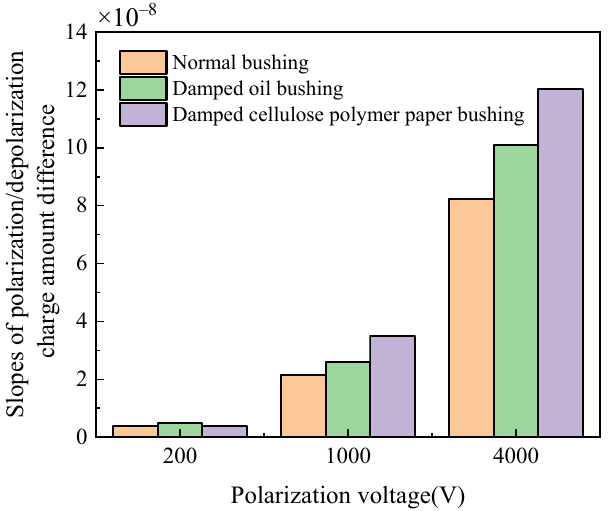
Figure 16. Slopes of charge amount difference curve at different applied DC voltages.